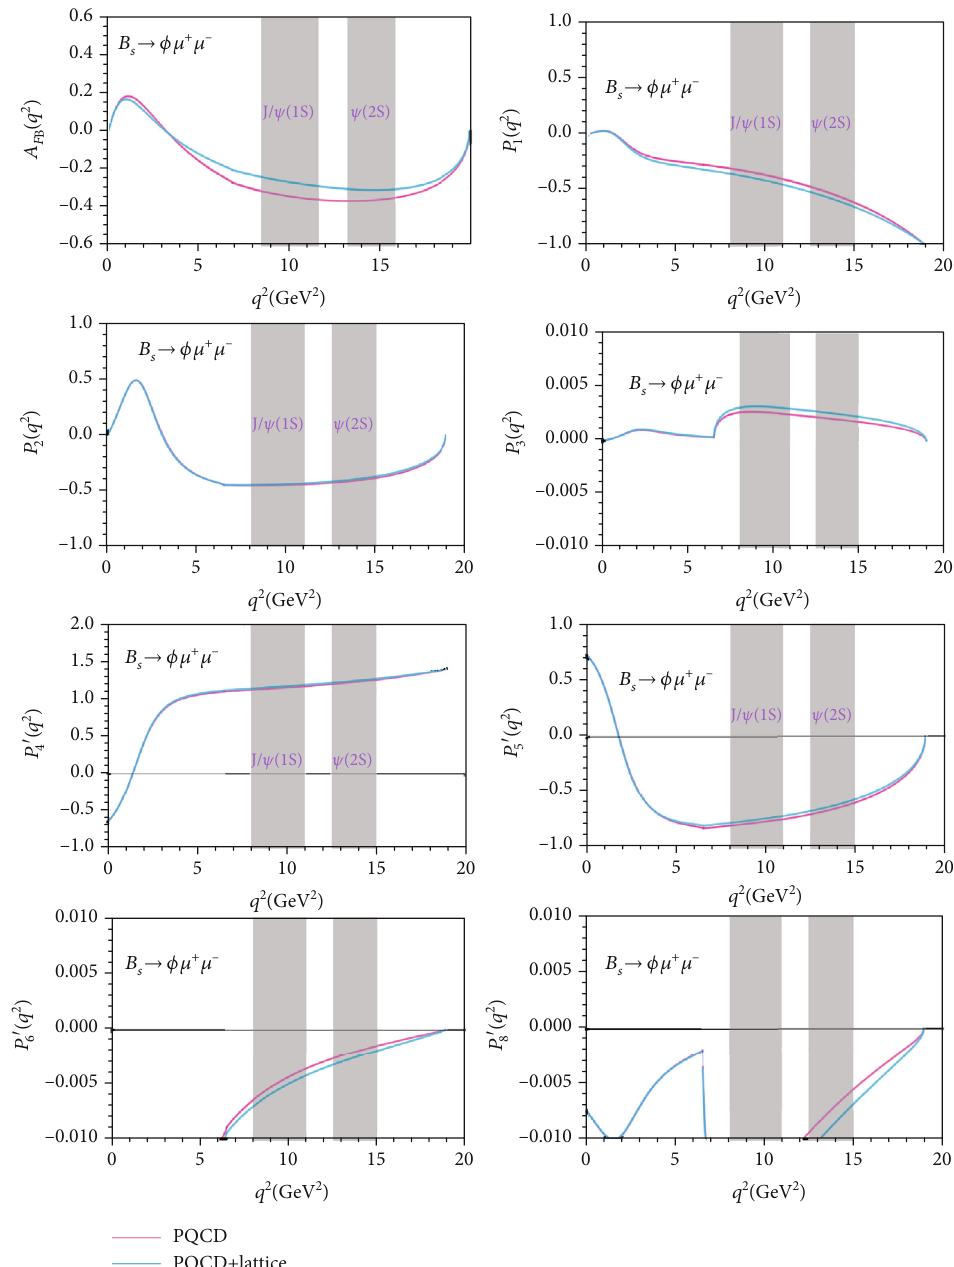
′ ð q 2 Þ for B ð q 2 Þ , P ð q 2 Þ , and P ⟶ ϕμ + μ − decay in the FB 1,2,3 4,5,6,8 s